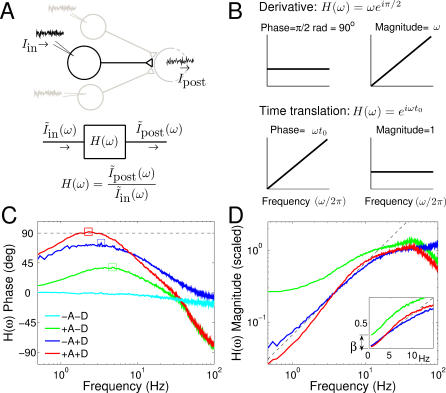
Fourier Analysis of the Network Model Output I
post upon Stimulation with White Noise Input Current I
in
In a range of low frequencies, networks with STD act as differentiators, and networks with SFA have a low-pass cutoff at neighboring frequencies.(A) Schematic representation of the model and the computation of its transfer function H(ω) from the Fourier transforms of I
in

and of I
post

. H(ω) is an imaginary quantity that is characterized by its magnitude and its phase.
(B) Phase and magnitude of the H(ω) for mathematical derivative (top) or time-shift (bottom) operators.(C) H(ω) phase and (D) H(ω) magnitude for Γ = 0.5, τD = 400 ms, and τCa = 80 ms in the network models of Figure 1 (same color code). To reduce the variance of H(ω), a network with N = 1,000 presynaptic neurons was used and responses to 50 different white noise realizations were averaged together. Significant phase advancement with linear increasing amplitude occurs for frequencies below 10 Hz when the network includes STD. On a single trial basis, however, only-STD networks produce unsatisfactory, very noisy I
post (Figures 1 and 4).(D) Every curve is scaled independently to match the initial slopes of |H(ω)| and to allow for comparisons. Inset: low-frequency range on linear scales.